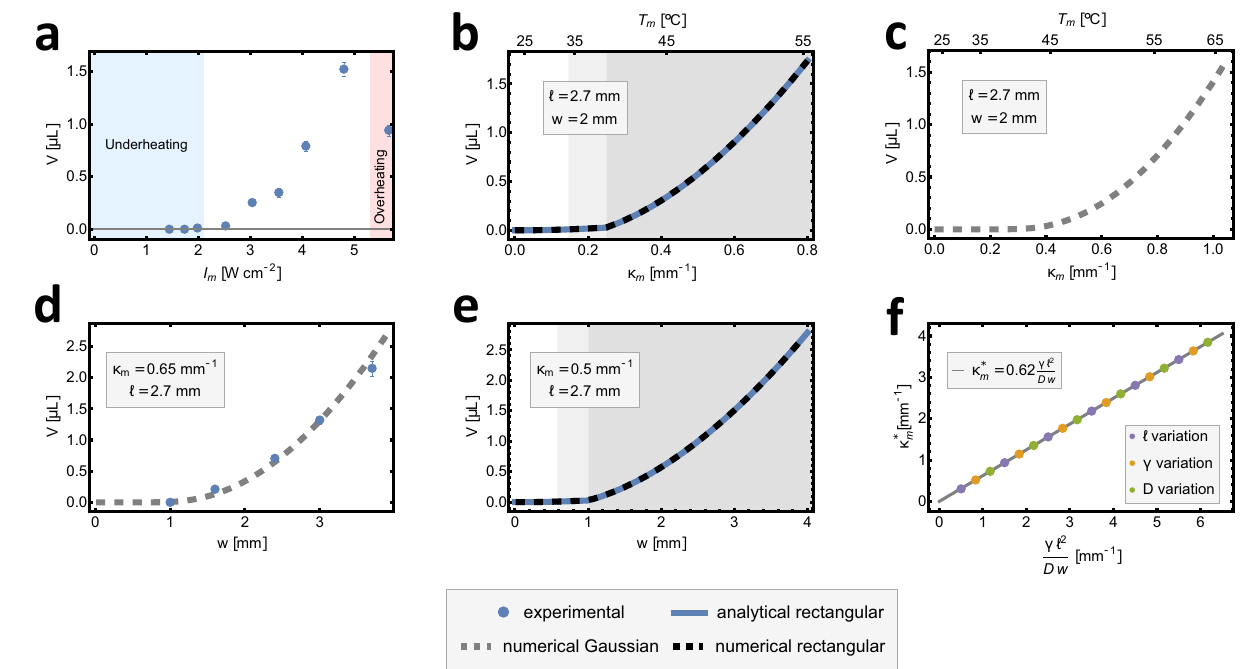
Fig.3|Volumecurvesshowingthethresholdsforboththeexperimentandthe theory. a – c Volume transported in a single scan depending on the maximal intensity ofthe laser beamor,inthe case oftheory, themaximalcurvature. A clear threshold behaviour can be seen in experimental and theoretical plots. The tem- perature axis corresponds to the peak temperatures calculated from curvature- temperaturedatapresentedinFig.S6. d , e Asimilarthresholdwasobserved( d )and predicted ( d Gaussian, e rectangular) when the width of the strip was varied. The